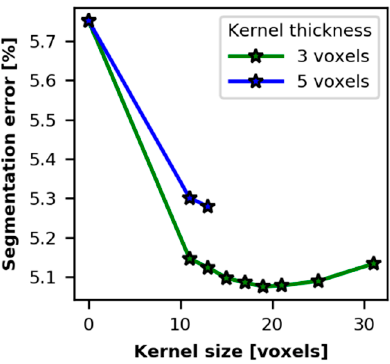
Figure 8. Impact of kernel size of the median filter on the voxel-wise segmentation error.